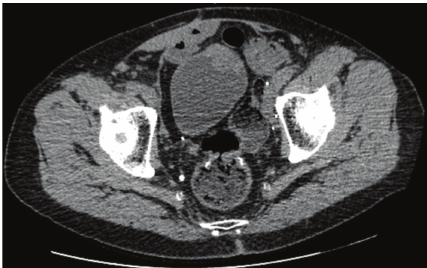
Figure 1: Abdominal CT-scan: lesion of the anterior wall of the neobladder.